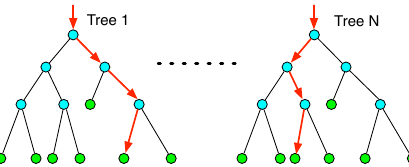
Figure 10. Random forest (RF). The RF consists of a number of decision trees. After splitting, each tree contains green leaf nodes and blue split nodes. For a particular input, the red arrows indicate the different paths from the root node to the left nodes along different trees. The final result is based on the maximum voting among all of the